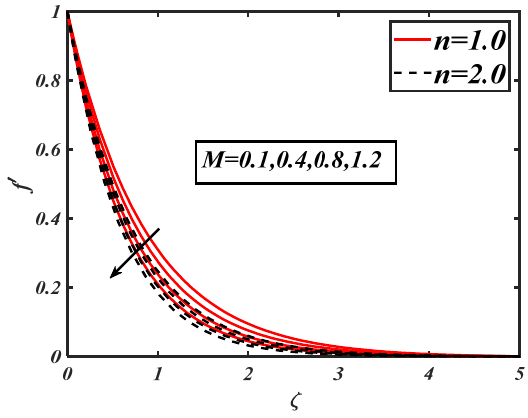
Figure 2. M illustration against f (cid:48) .